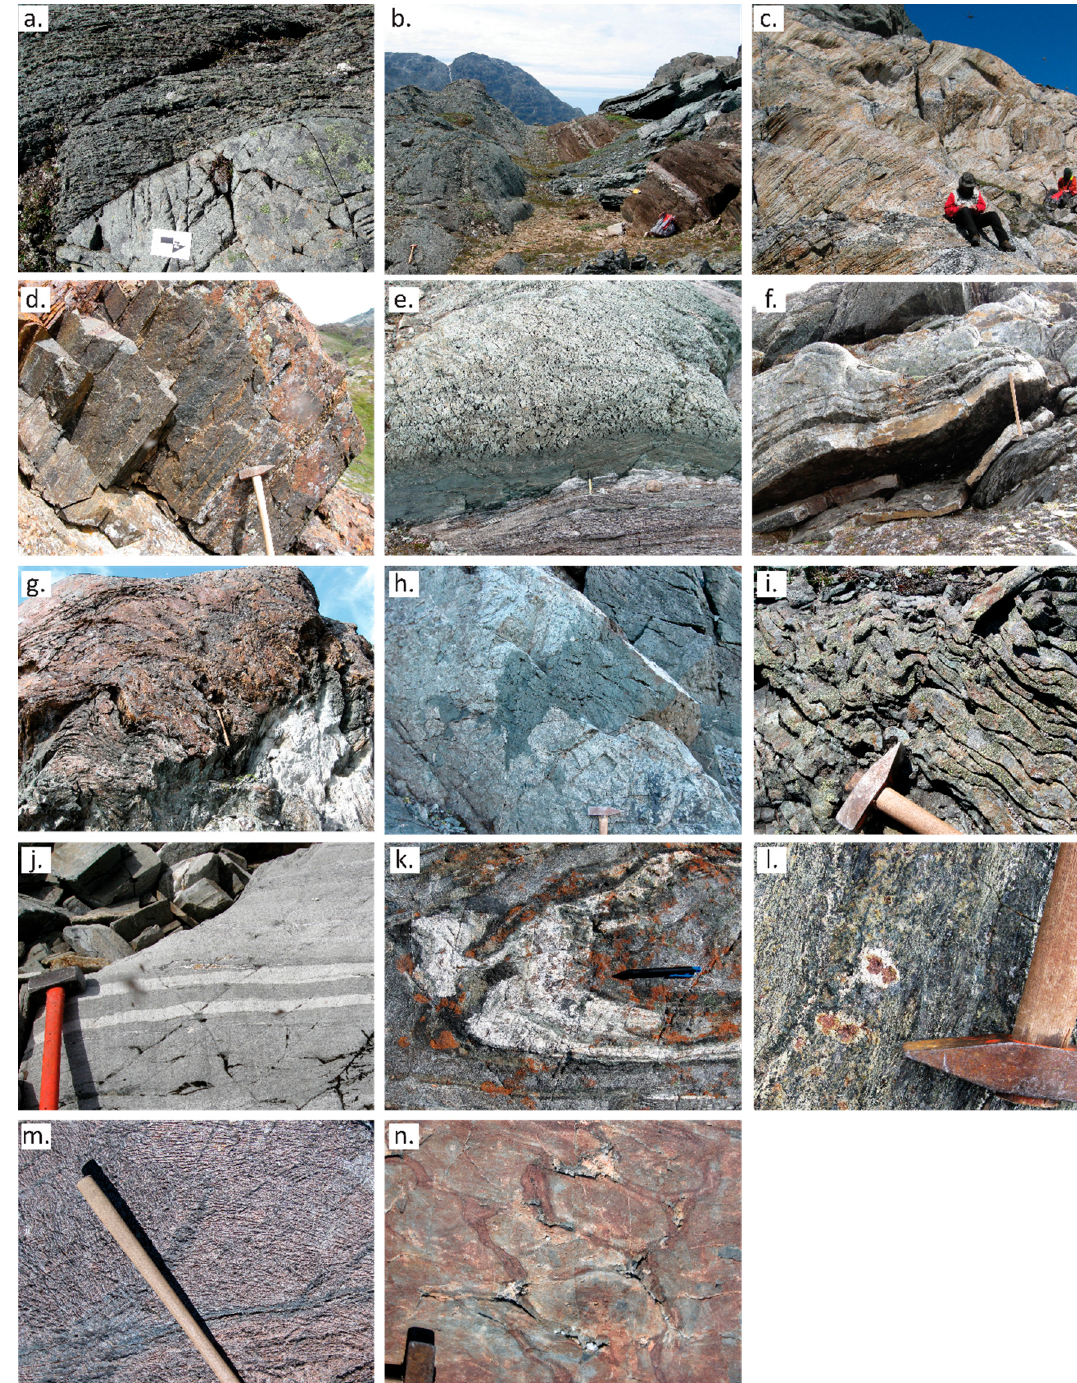
Figure 2. Field photographs of characteristic lithologies and textures in the Tartoq belt; ( a ) Greenschist with boudins of greenstone in Nuuluk; ( b ) Overview of the Eastern Carbonate Zone with brown chlorite-ankerite schists at the base of the shearzone; ( c ) Felsic mylonite in Nuuluk; ( d ) Laminated chert horizon in southern Nuuluk; ( e ) Metasomatic reaction zone between knobbly greenschist (at top) and ultramafic rock in Iterlak with grey talc schist and green actinolite zone; ( f ) Felsic thrust sheet in Iterlak with talc schists at its base; ( g ) metasomatic iron formation adjacent to talc schist in eastern Iterlak; ( h ) Mingling textures in Amitsuarsua amphibolite; ( i ) Weathered out carbonate in between the greenschist foliation; ( j ) Compositional variations in Bikuben amphibolite; ( k ) Anatectic melts pooling in, and breaking through fold hinges in Bikuben; ( l ) Leucocratic rims on garnet in Bikuben calc-silicate rocks; ( m ) Pseudo-spinifex texture in Bikuben ultramafic rock; ( n ) Pillow textures in Nuna Qaqortoq amphibolites.